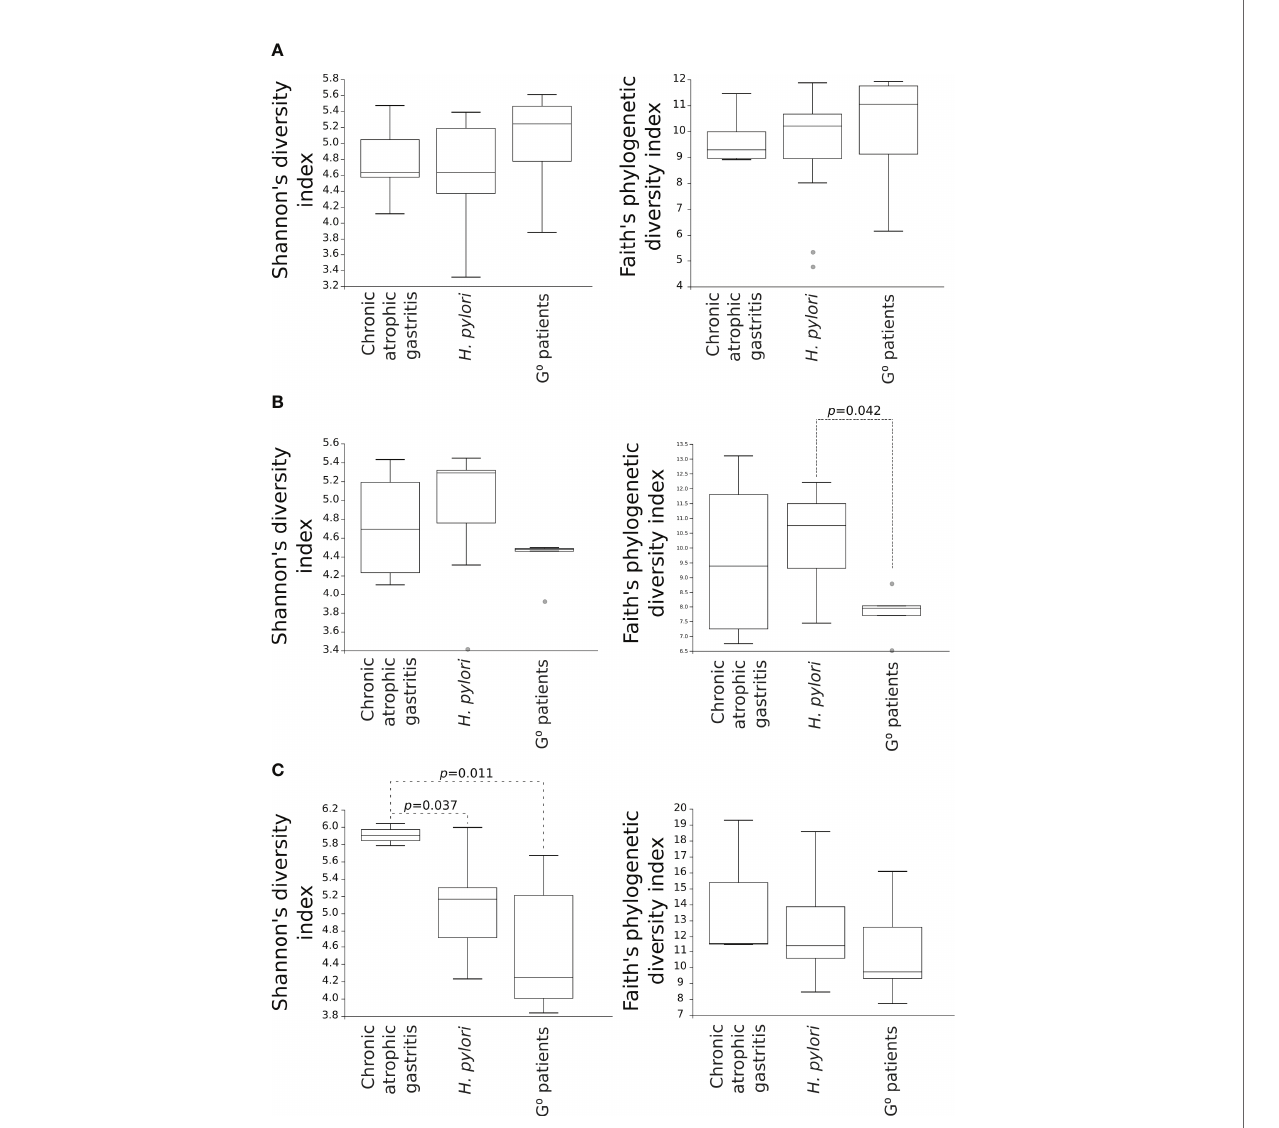
Streptococcus , LDA > 5.0, p =0.02), Fusobacteria (speci fi cally the class